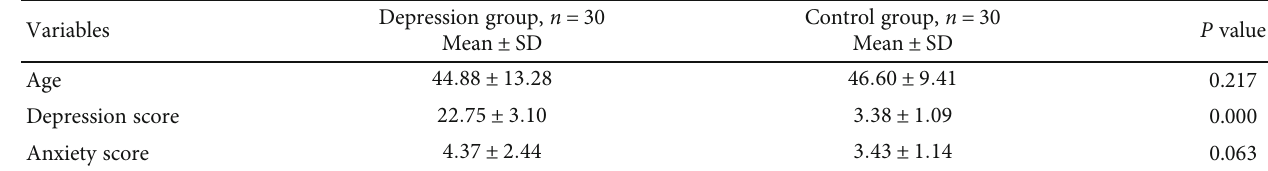
Table 1: Comparison of demographic data between depression and control groups.